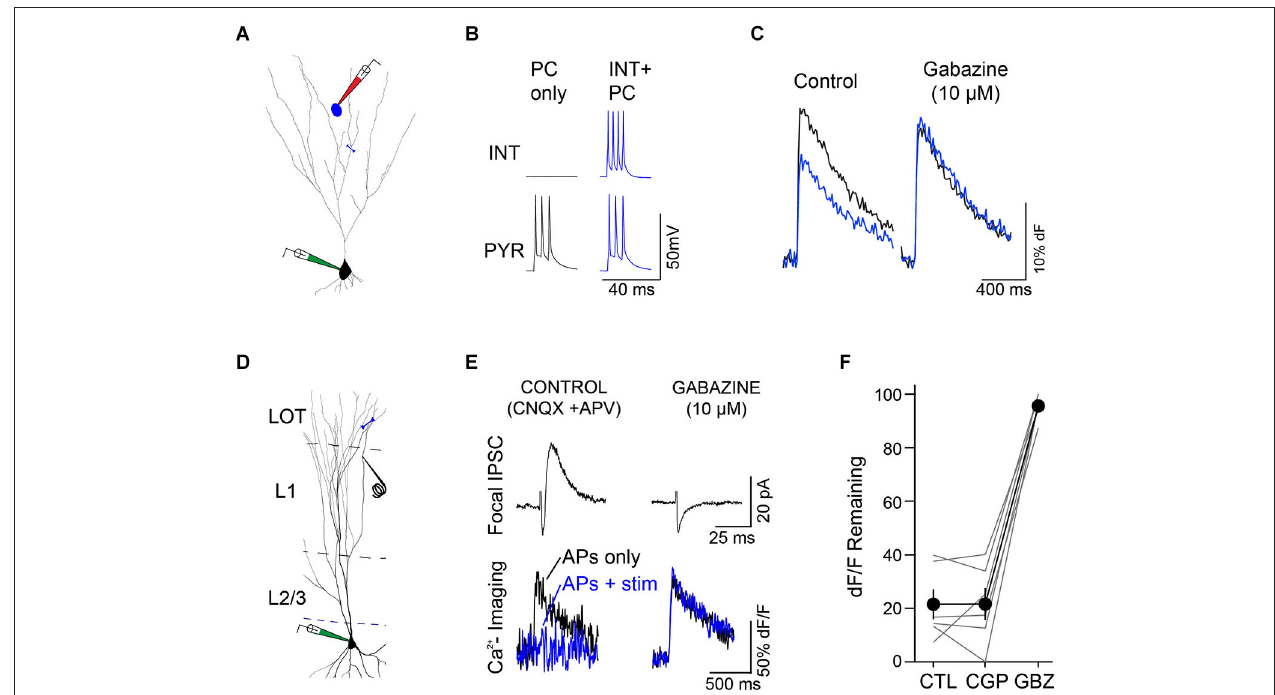
line) were performed. Experiments were performed in the presence of glutamate receptor antagonists (CNQX, 10 µ M and D-APV, 50 µ M) to isolate inhibitory synaptic transmission. (E) Representative experiment. Left, top: focal stimulation elicited a small inhibitory postsynaptic current (IPSC (black trace, V m = − 45 mV) in the PC. Bottom: bAP-evoked Ca 2 + transients in the PC (black trace) were strongly reduced during a train (6 pulses, 100 Hz) of L1 stimuli (blue traces). Right, application of gabazine (10 µ M) eliminated the L1-evoked IPSC (top) and abolished the effect of L1 stimulation on the PC bAP-evoked Ca 2 + transients. (F) Summary ( n = 6 cells, lines represent individual cells, circles indicate mean ± SEM) demonstrating that suppression of bAP-evoked Ca 2 + transients by focal L1 stimulation is unaffected by the GABA B receptor antagonist CGP 55845 (10 µ M, CGP) but completely blocked by subsequent application of gabazine (10 µ M,